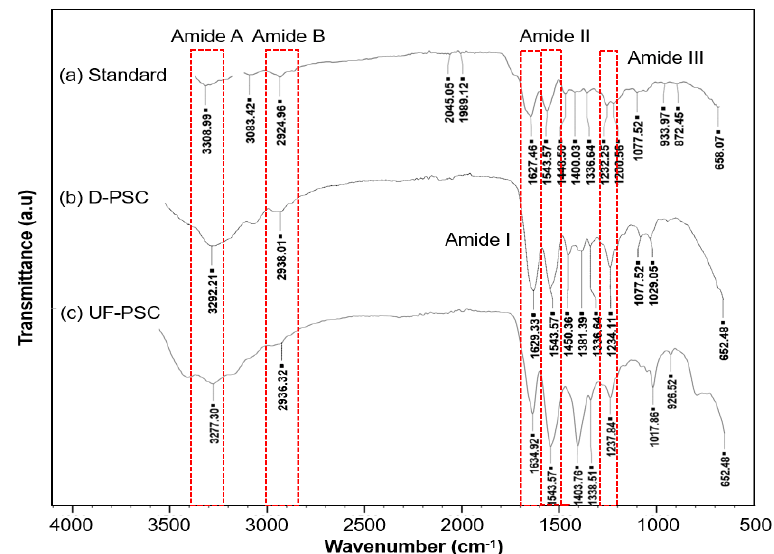
Figure 2. FTIR spectra of collagen ( a ) standard collagen (calf skin); ( b ) collagen isolated using dialysis, D-PSC; and ( c ) collagen isolated using ultrafiltration, UF-PSC.